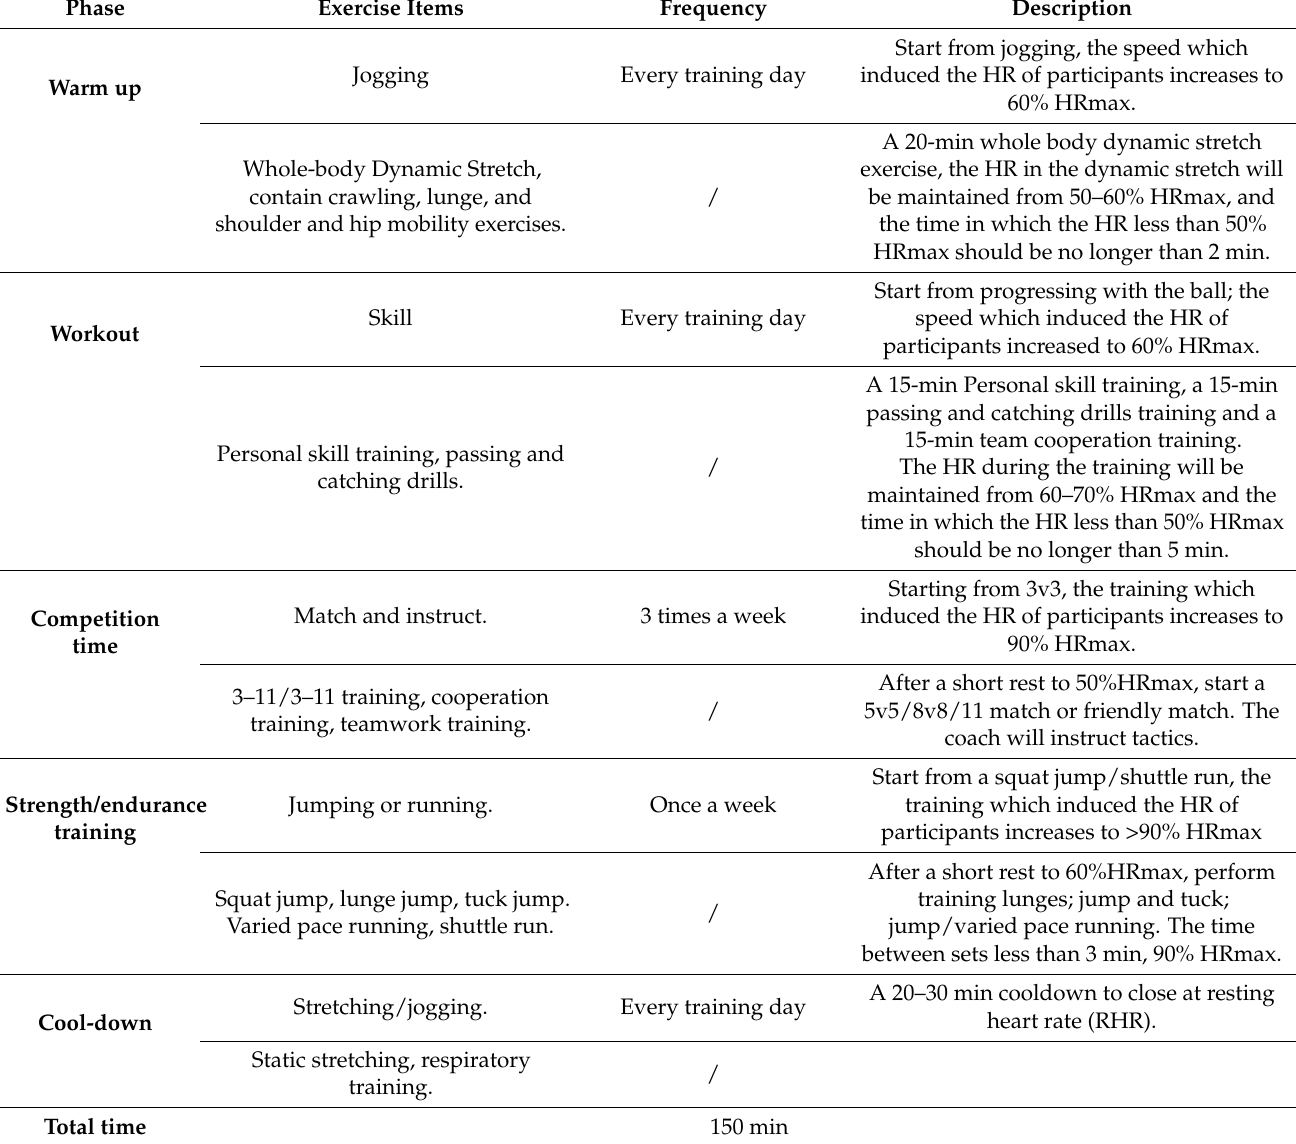
Table 3. Details of the training plan in the